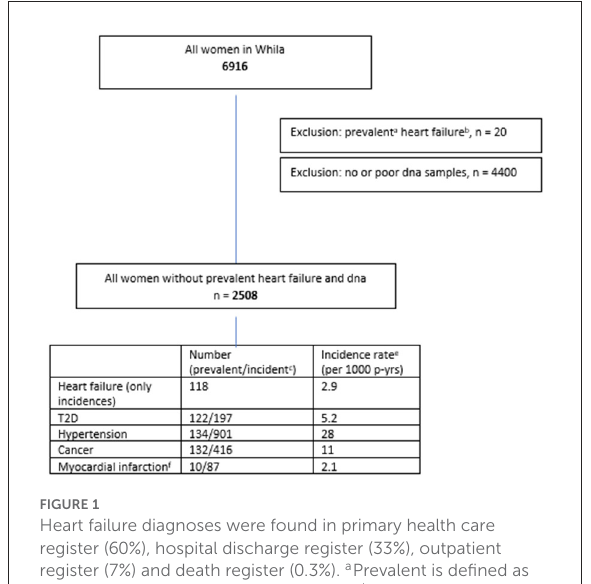
FIGURE1 Heart failure diagnoses were found in primary health care register (60%), hospital discharge register (33%), outpatient register (7%) and death register (0.3%). a Prevalent is defined as first diagnose date before or at baseline. b Heart failure icd-codes = I50, I110, 428, 427.00, 427.10, 434.10, and 434.20. c Incident is defined as first diagnose date after